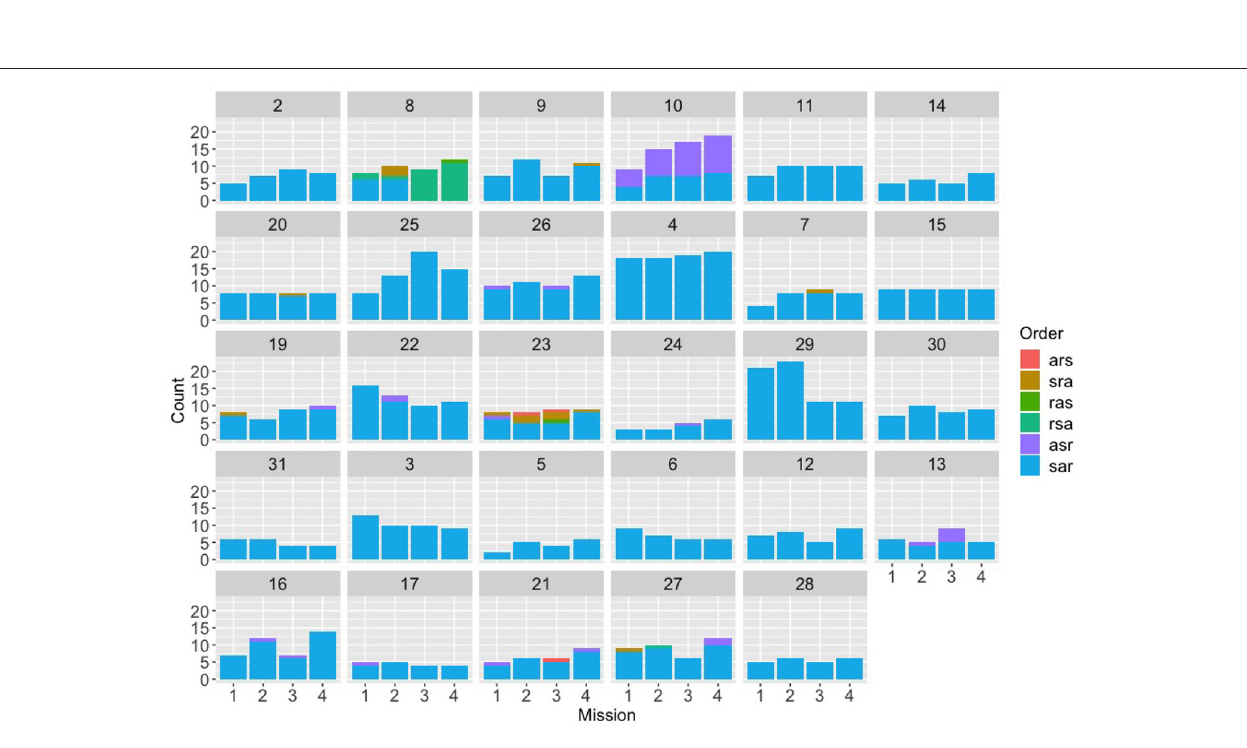
FIGURE 4 | Counts for each of the six possible orders for (s)peed, (a)ltitude, and (r)adius, across the first four missions for the evaluation experiment, broken down by team. The first nine teams (2-26) were in the control condition; the next 10 teams (4-31) were in the expert condition; the last 10 teams (3-28) were in the synthetic teammate